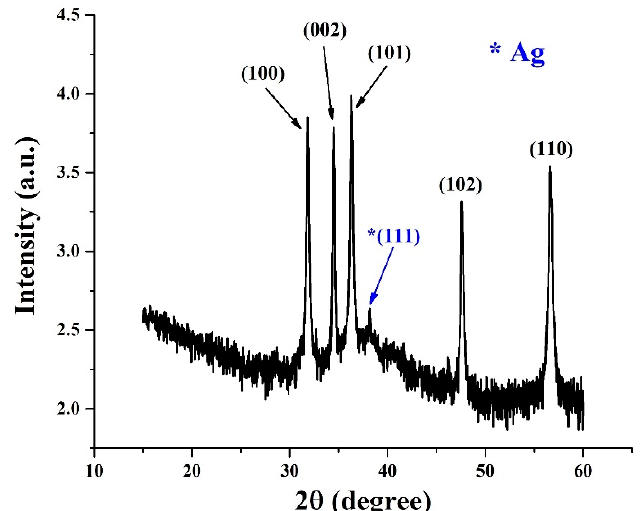
Figure 2. XRD pattern of as-prepared ZnO-Ag